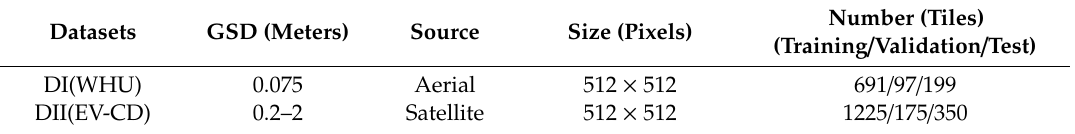
Table 1. Information of our datasets for experiments.